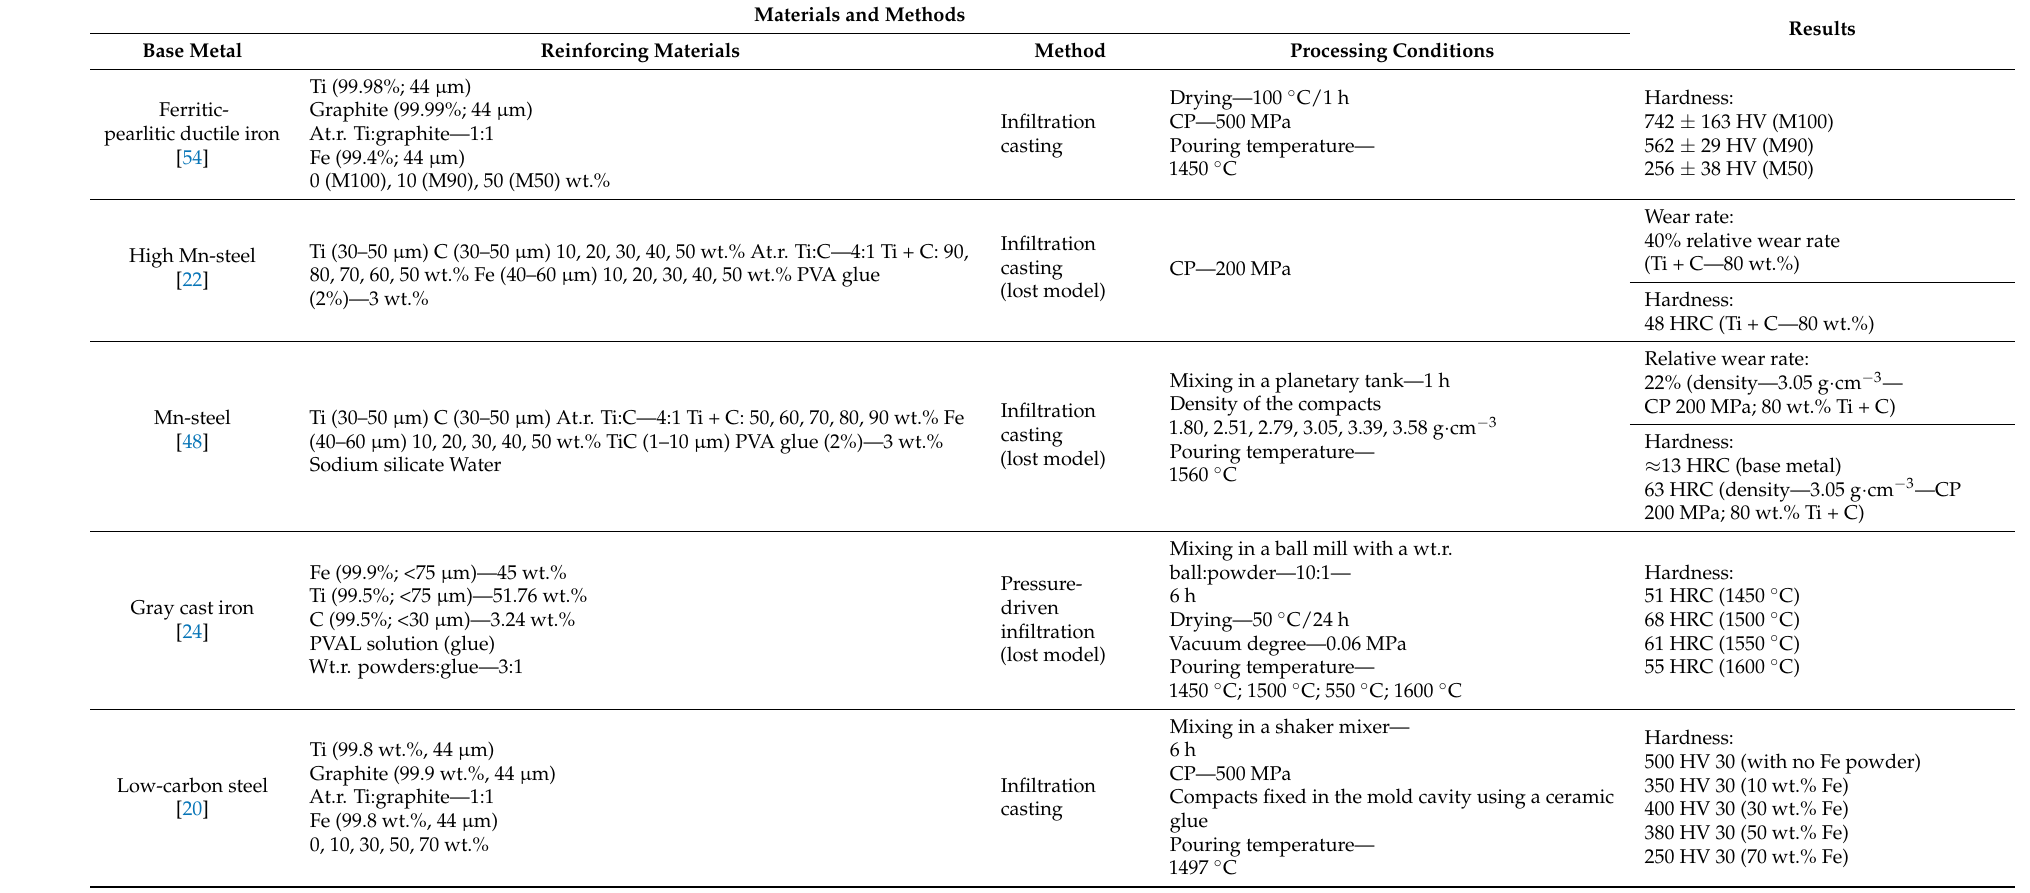
Table 4. Summary of experimental conditions and main results of SHS/casting processing using Fe-Ti-C powder